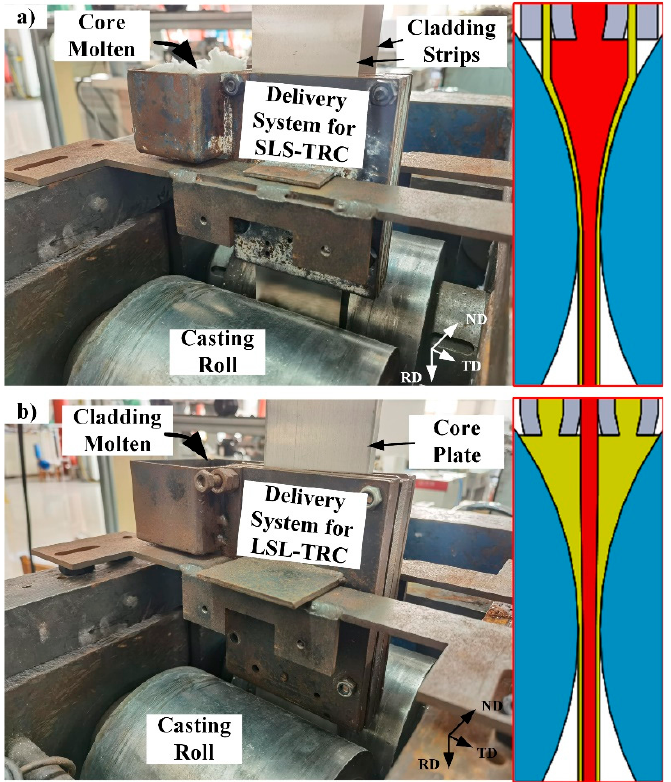
Figure 1. Schematic diagram of SLS-TRC and LSL-TRC process of three-laminated aluminum com- posite plate. ( a ) SLS-TRC; ( b ) LSL-TRC. composite plate. ( a ) SLS-TRC; ( b )